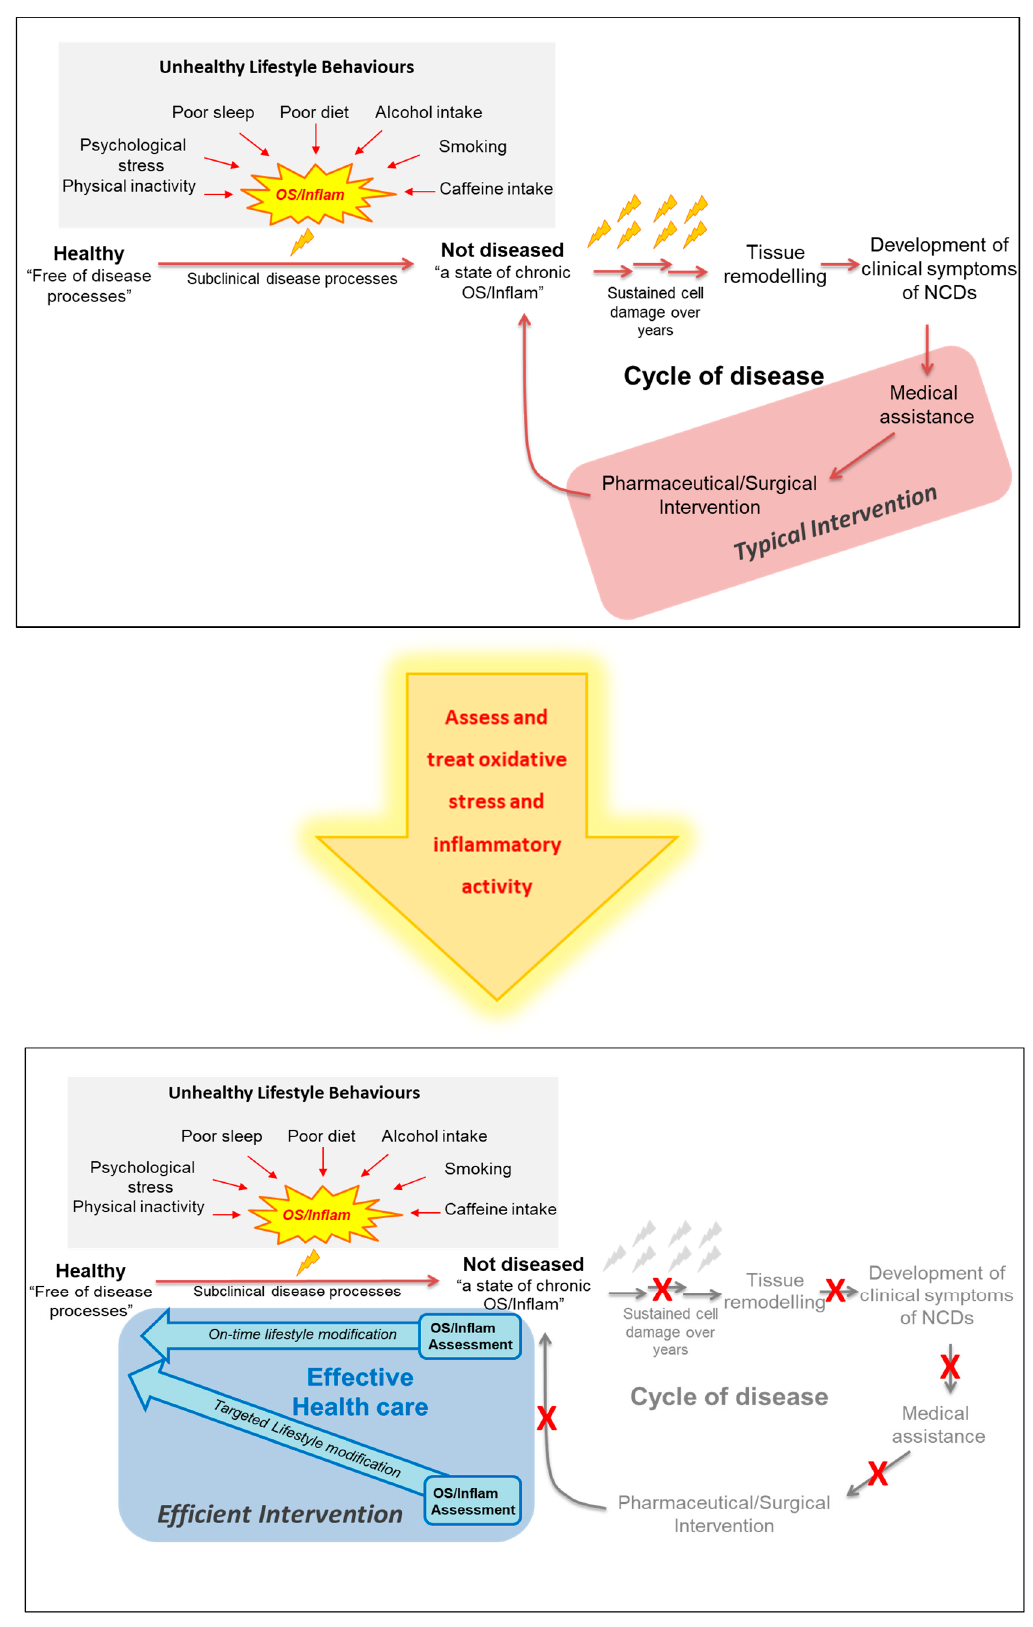
Figure 5. A suggested model for a more effective approach to treatment/prevention of the non-communicable diseases. NCDs: non-communicable disease; OS: oxidative stress; Inflam: Inflammation.